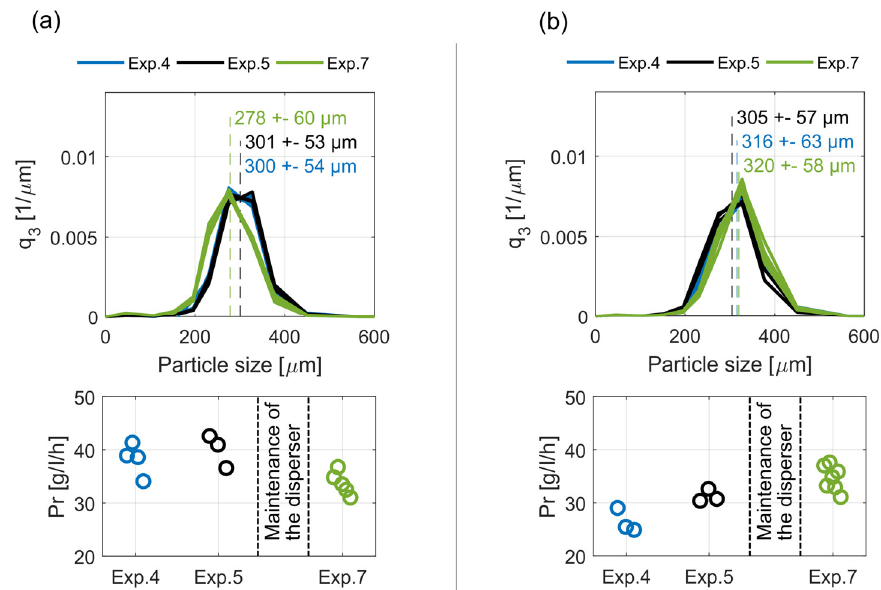
Figure 7. Steady-state crystal size distributions, q 3 , with their respective mean values and standard deviations, as well as the corresponding productivities, Pr, of crystallizer C2 ( a ) and C1 ( b ) for Exps. 4, 5, 7.